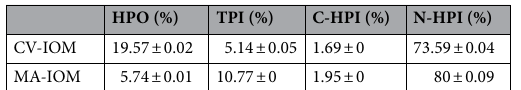
Table 3. Hydrophilic properties of CV-IOM and